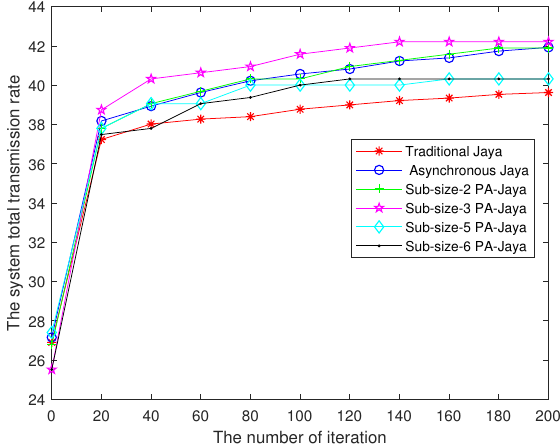
Figure 3. Performance comparison of different Jaya